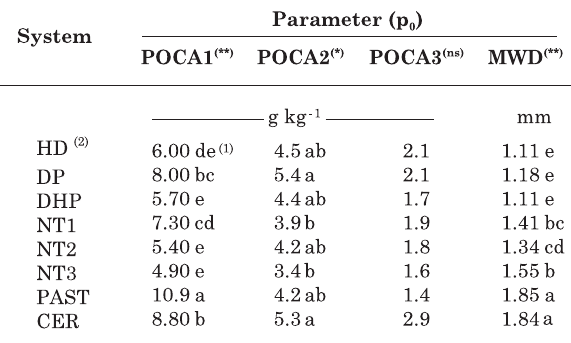
Table 6. Comparison of parameter p